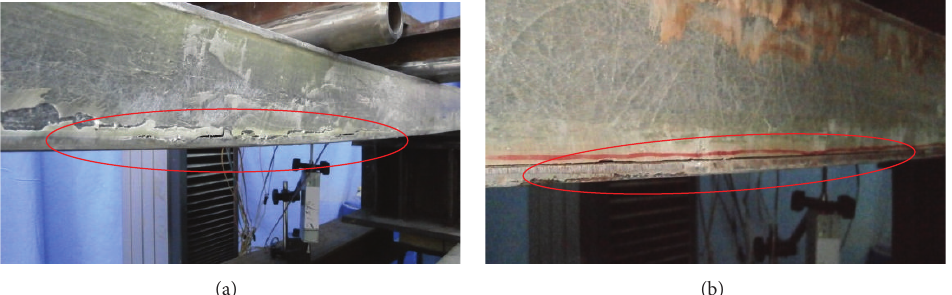
Figure 6: Failure of specimen S( 6 )-GFRP: (a) web peeling off from the lower facesheet and (b) web on the other side peeling off from the lower facesheet.